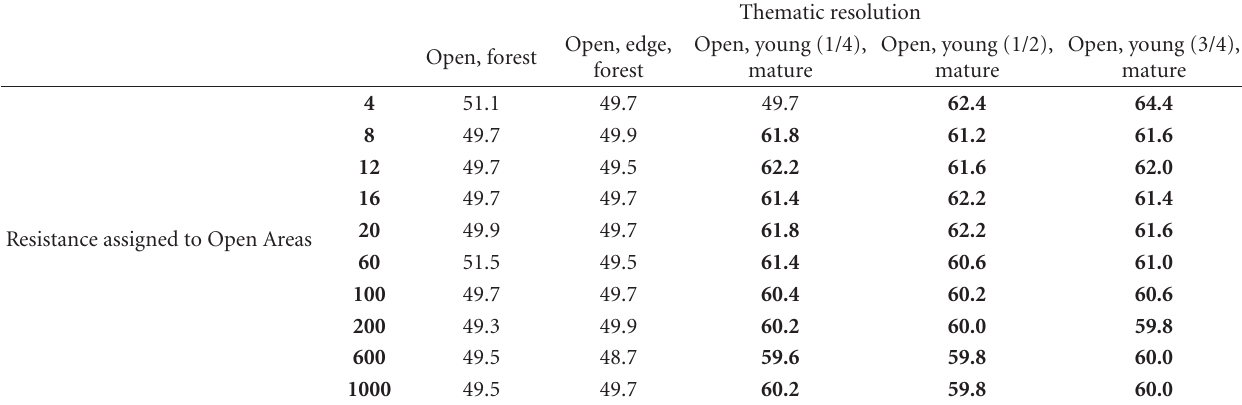
Table 4: Percentage of the 500 simulation for which mean distance is smaller than the median of mean distances for null model of the corresponding year. Fractions in parentheses represent resistance in young forest relative to resistance in open areas. Percentages significantly greater than 50 (better than null model) are shown in bold typeface. Results with 100 m grain are shown.